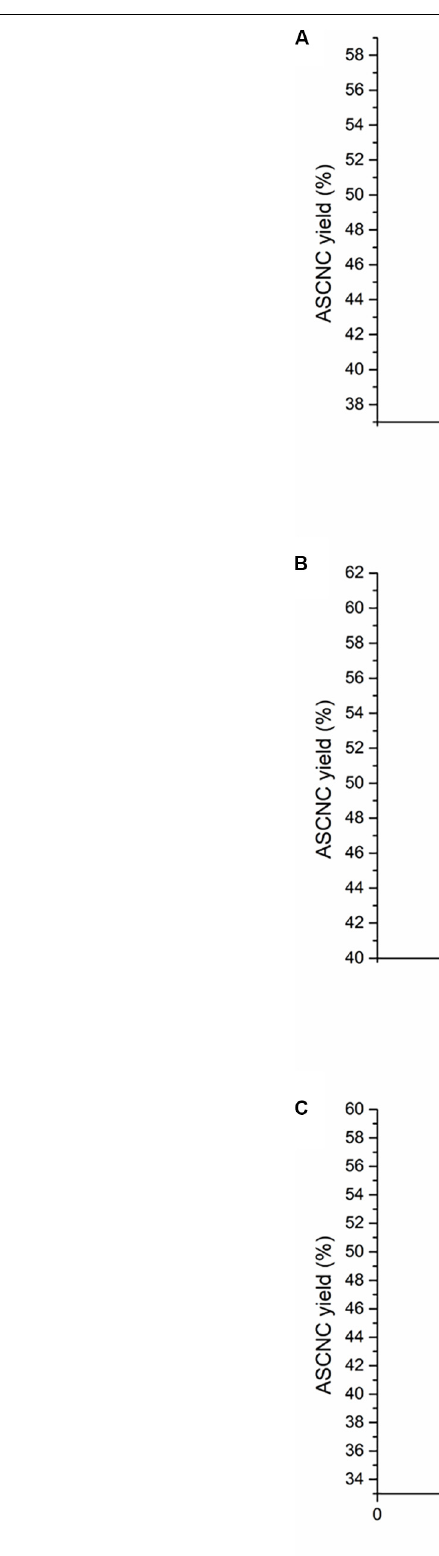
Frontiers in Bioengineering and Biotechnology |